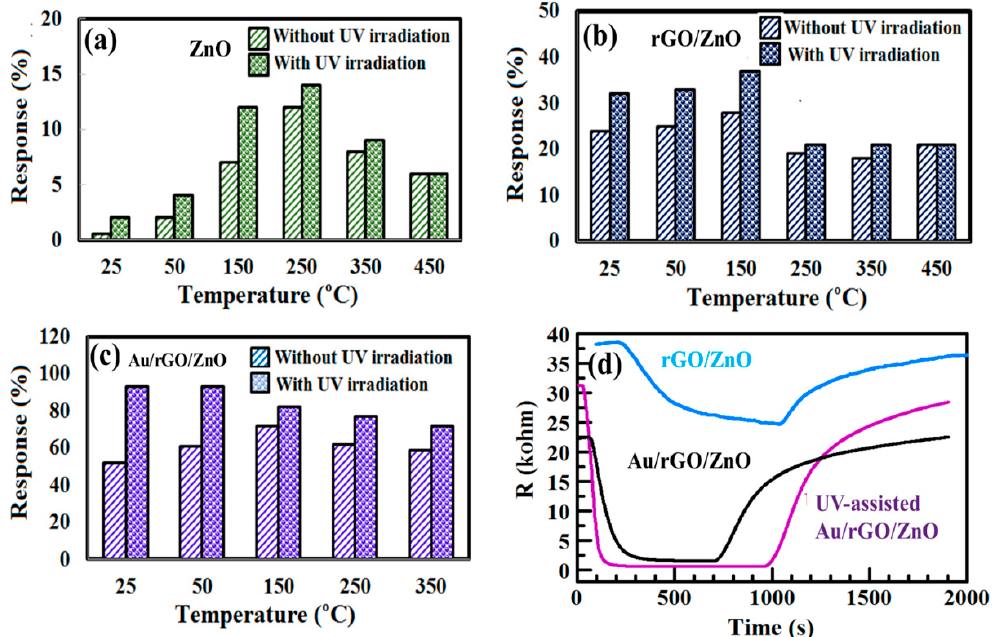
Figure 10. ( a – c ) Responses at different temperatures of ZnO, rGO/ZnO, and Au/rGO/ZnO sensor with and without UV irradiation; ( d ) Dynamic response at room temperature of rGO, Au/rGO/ZnO, and UV activated Au/rGO/ZnO [128] . Copyright (2020), with permission from Elsevier.